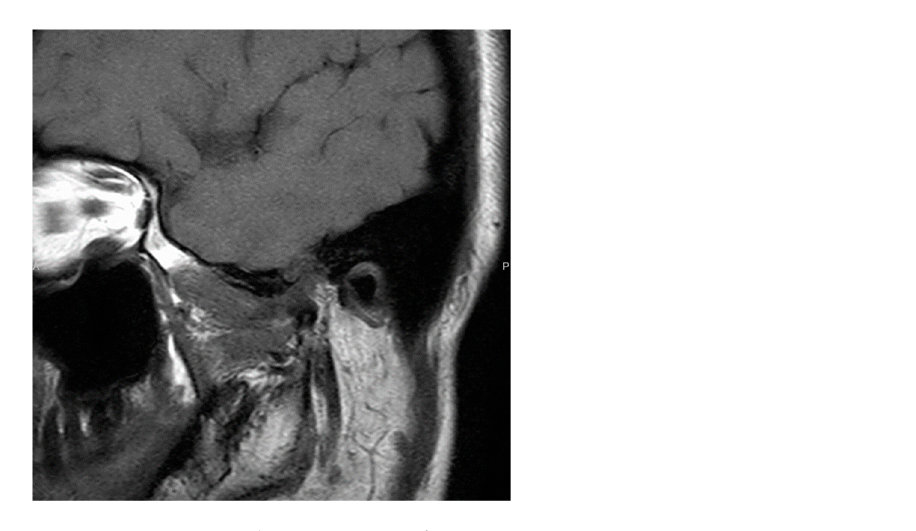
Figure 8. Immunostaining findings in patient 2. Immunostaining with labeled anti-Gli1 antibody. These findings are similar to those in patient 1.